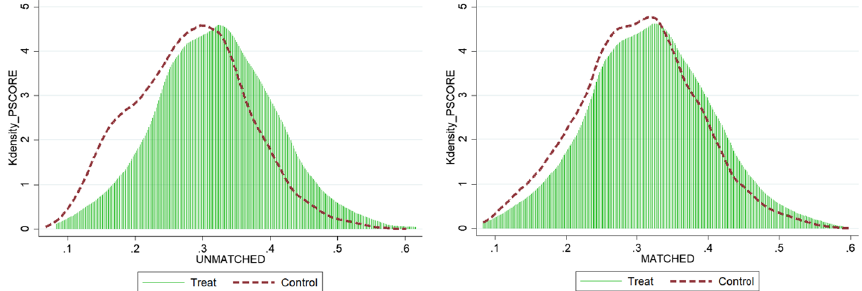
Fig. 4 The kernel density distribution of